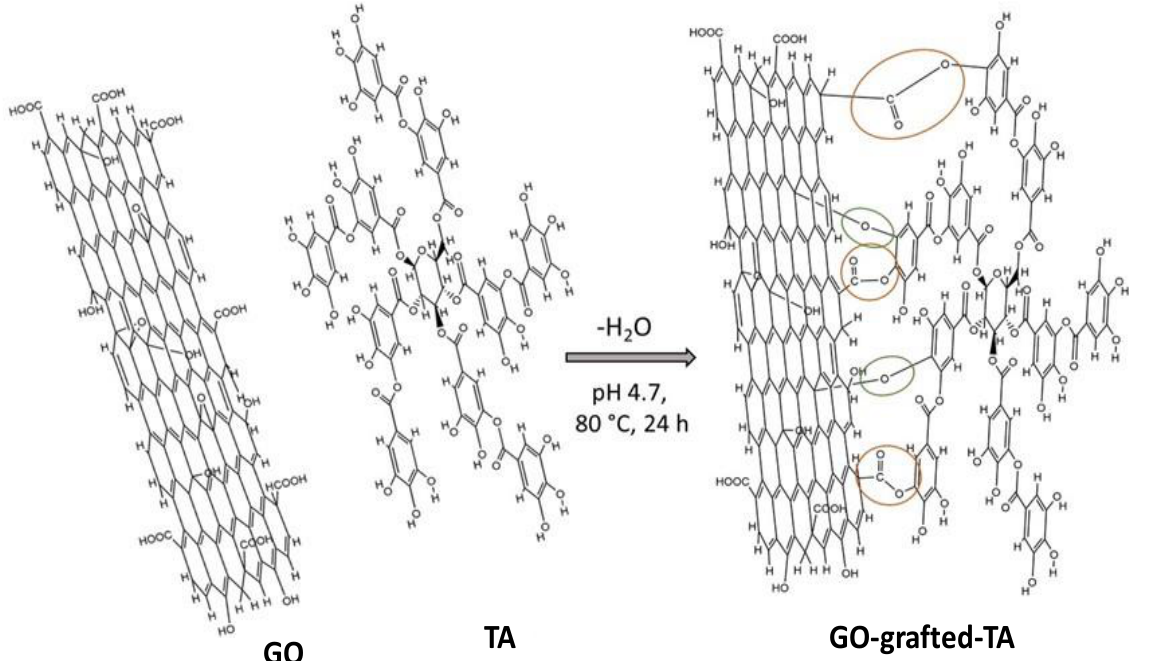
Figure 4. Representation of the covalent functionalization of graphene oxide (GO) with a biological macromolecule, tannic acid (TA) via formation of ether and ester linkages. Reproduced from Ref. [45], copyright 2022, with permission from Elsevier.